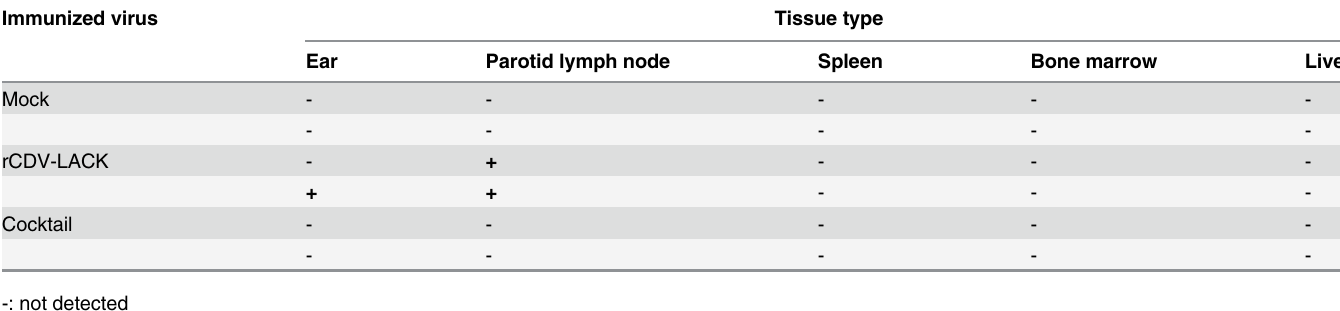
Table 1. Detection of L . major at the 10th week post